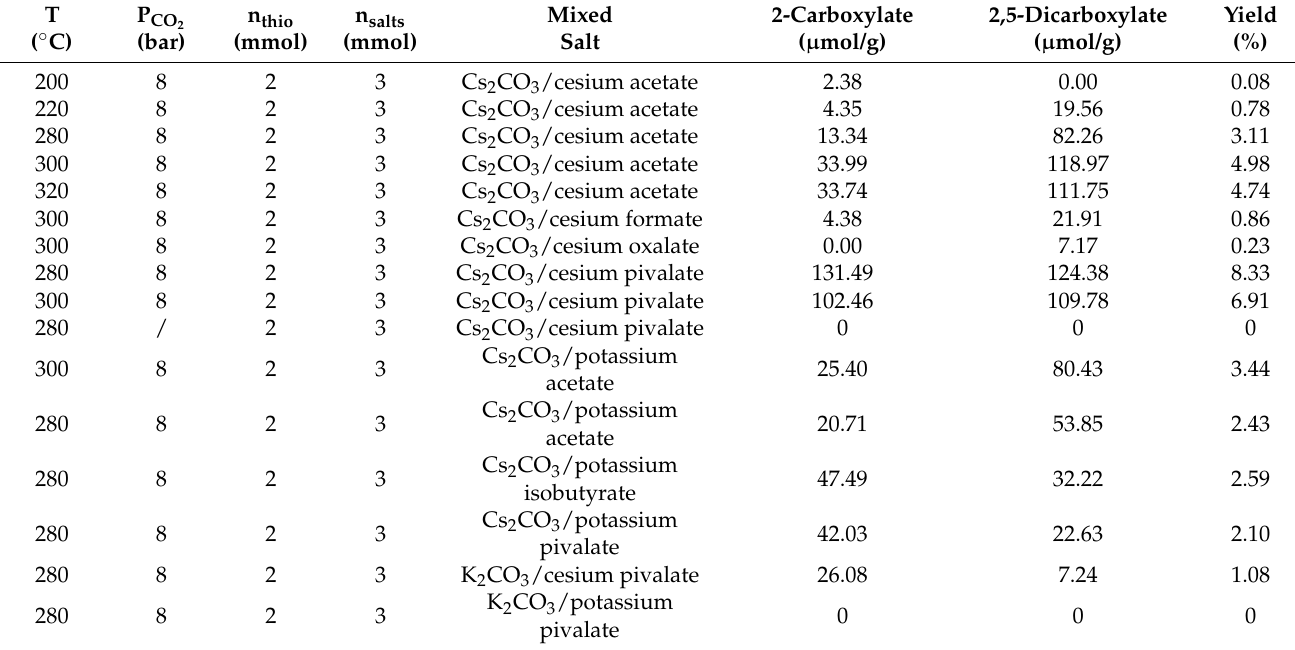
Table 1. Summary reaction results for thiophene carboxylation as the function of temperature and salts.